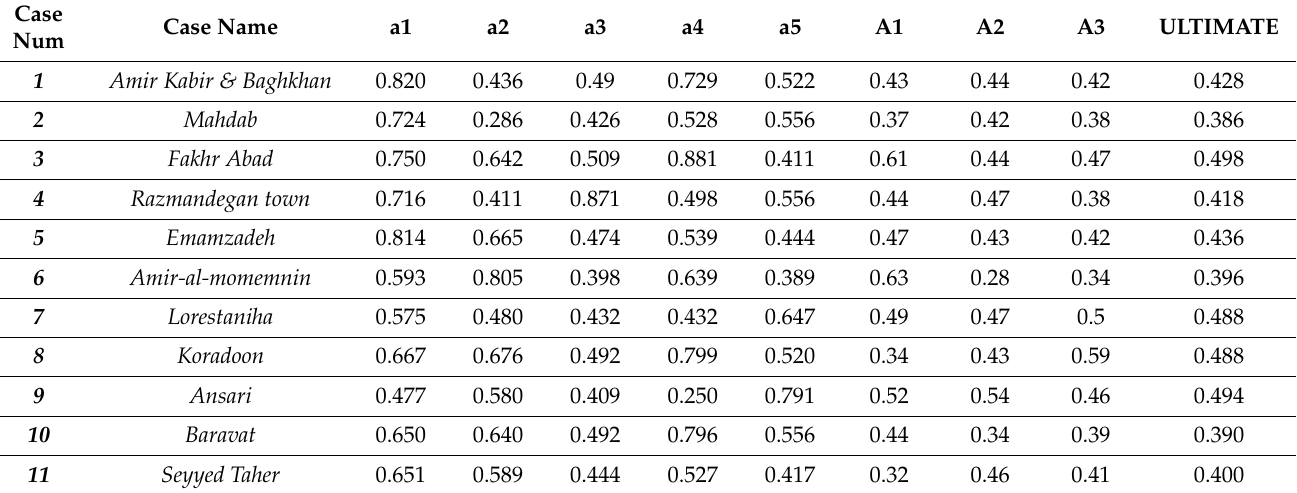
Table 4. Truth table; case